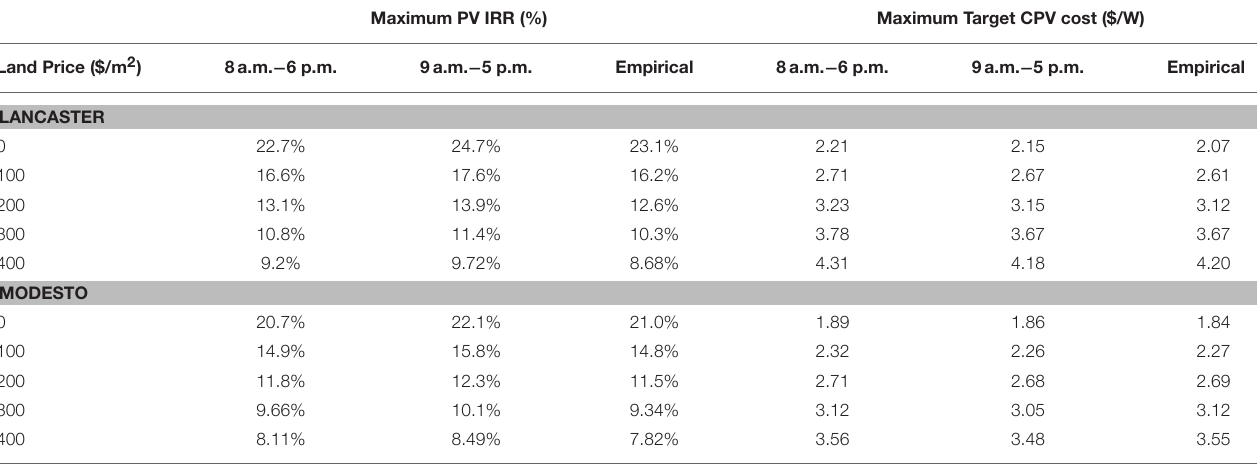
TABLE 5 | Optimal PV IRR under 3 load profiles in Lancaster and Modesto and the target CPV cost required to match that IRR for different land prices and a battery price of